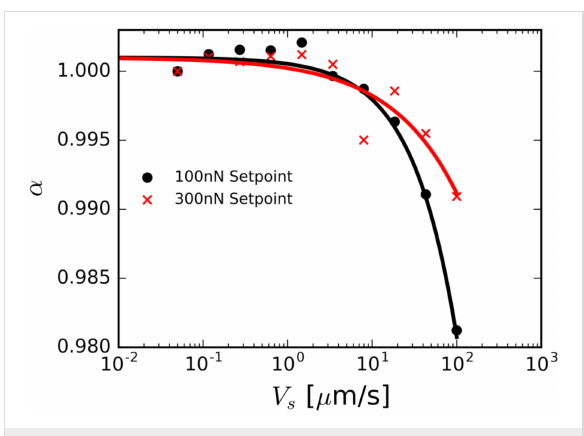
Figure 4: Measured normalized sample contact stiffness as a function of the scan speed. The red data indicates a force set-point of 300 nN. The black data indicates a force set-point of 100 nN.